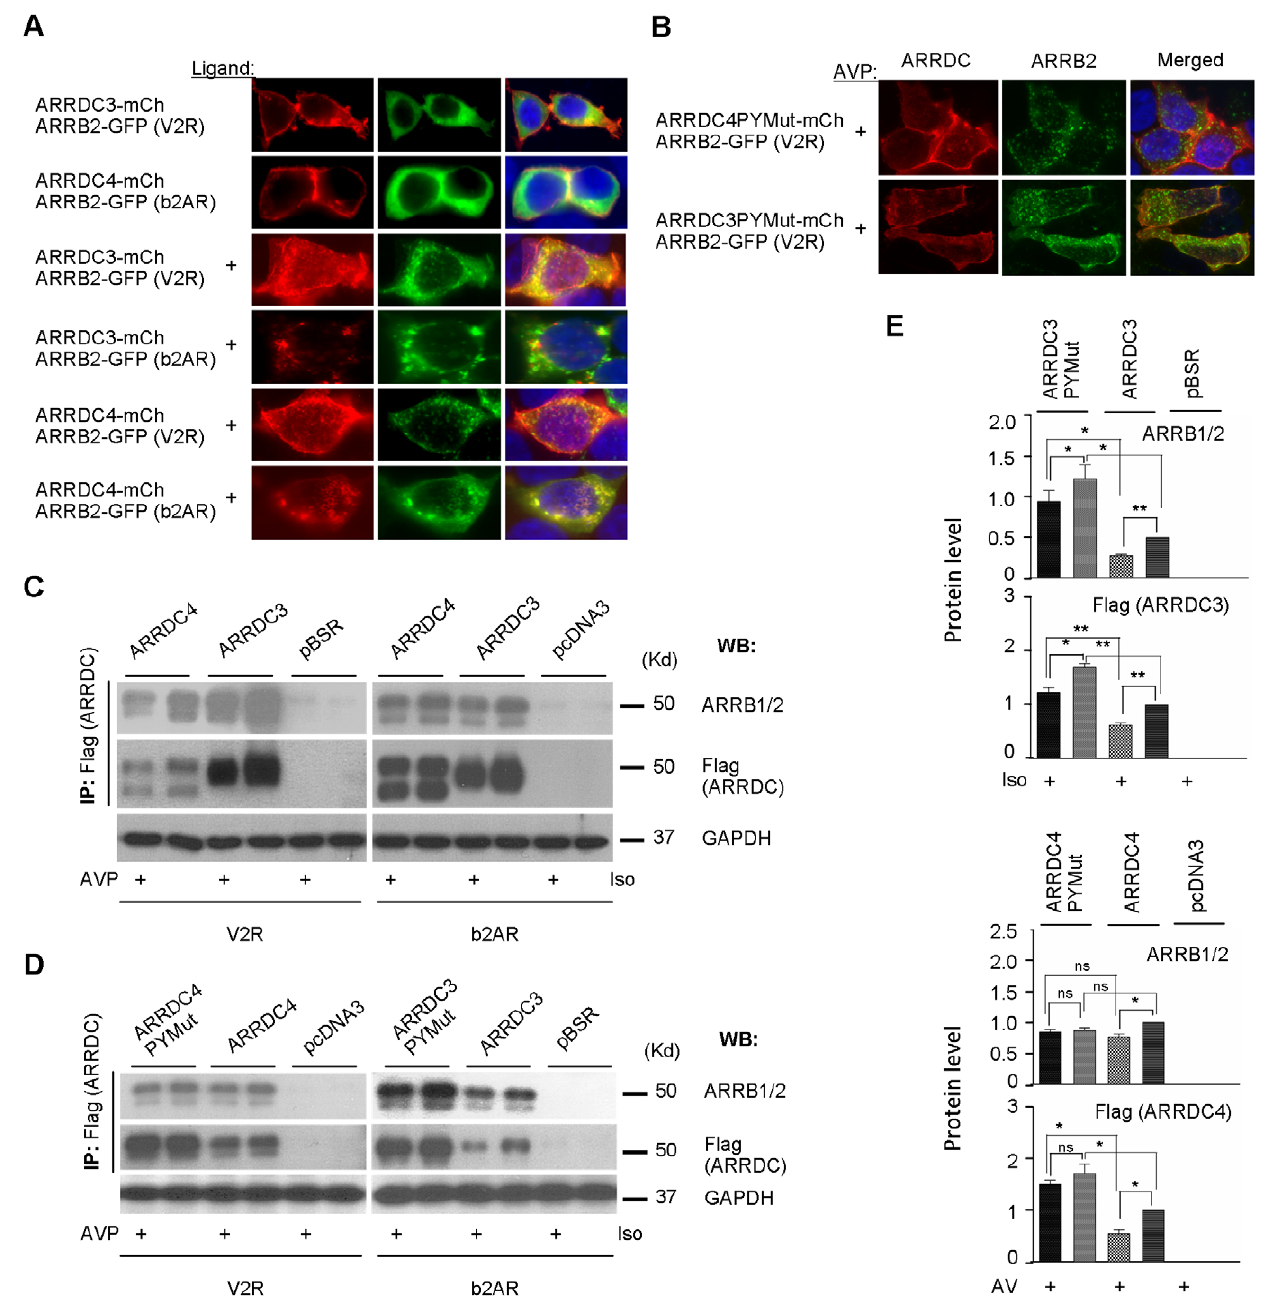
Figure 6. Hetero-association of alpha and beta arrestins. ( A ) Subcellular colocalization of alpha and beta arrestins in HA-b2AR and HA-V2R-V5 permanent cell lines. HA-b2AR and HA-V2R-V5 permanent cells were transiently co-transfected with either ARRDC3- or ARRDC4-mCherry construct plus pArrb2-EGFP. After 24 h, transfected cells were serum-starved for 2 h, treated or not with 1 uM ligand for 30 m, and then washed and fixed with 4% paraformaldehyde. Fluorescent confocal images were captured (aArr, red ; ARRB2, green ). ( B ) Subcellular colocalization of mutant alpha- and beta- arrestin in ligand treated V2R permanent cell line. HA-V2R-V5 permanent cells were transiently co-transfected with either ARRDC3- or ARRDC4- mCherry PY mutant construct plus pArrb2-EGFP. After 24 h, transfected cells were serum-starved for 2 h, treated with 1 uM AMP for 30 m, and then washed and fixed. Fluorescent confocal images were captured (aArr, red ; ARRB2, green ). ( C ) Co-immunoprecipitation of wild type aArrs and bArrs. HEK-293Tcells were co-transfected either with empty vector, or pBSR-ARRDC3-Flag, or pcDNA3-ARRDC4-Flag plus pcDNA3-HA-b2AR or pcDND3-HA- V2R-V5. After 24 h incubation, cells were serum-starved and treated or not with 1 uM ligand for 5 m. The cells were lysed, and lysates were immunoprecipitated and analyzed by western blot. ( D ) Co-immunoprecipitation of wild type or mutant aArrs and bArrs. HEK-293T cells were co- transfected either with empty vector, pBSR-ARRDC3-Flag, or pBSR-ARRDC3-Flag PY mutant, plus pcDNA3-HA-b2AR. Protein levels of ARRB1/2 and aArrs were detected by western blot. ( E ) The same concept as in D was done with ARRDC4 plus HA-V2R-V5. P-values were calculated by paired, two- tailed t-tests (p values and thin/bold lines used as in Fig. 2).